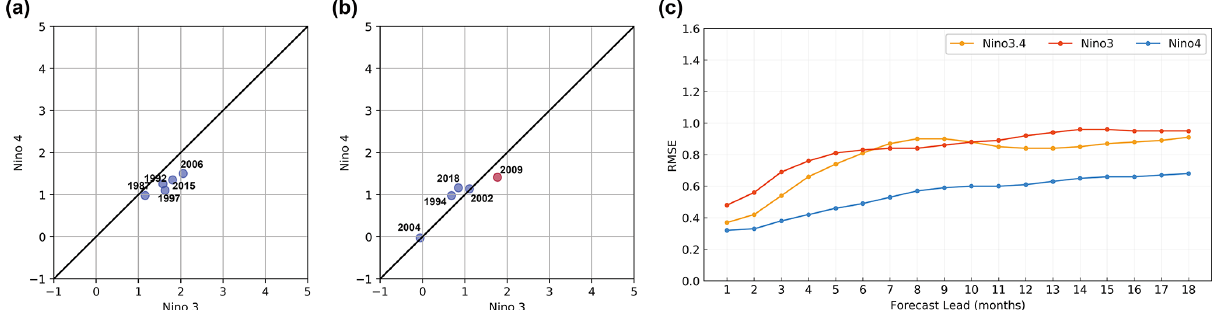
Figure 12. Scatterplots in Niño 3–Niño 4 index plane of 12-month-lead predictions for all (a) EP El Niño events and (b) CP El Niño events during the peak phase from 1984 to 2019. (c) Root mean square error (RMSE) of the Niño 3.4, Niño 3 and Niño 4 indexes between the forecast results of the ENSO-MC model and observations during the validation period.